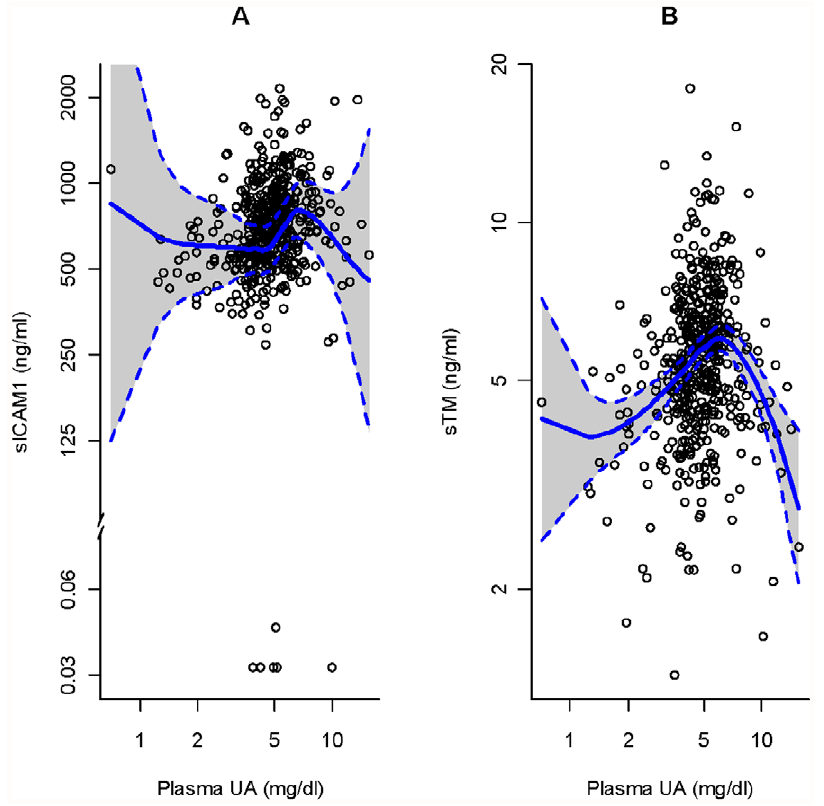
Figure 2. Correlations between plasma levels of UA and those of sICAM-1 or sTM during an acute episode of P.falciparum malaria. The levels of UA, sICAM-1 and sTM were quantified in plasma samples from 487 Malian children at their first episode of uncomplicated P. falciparum malaria and their relationships analyzed. A. The graph shows a positive linear correlation between UA and sICAM-1 levels, but not at the lowest and highest UA levels measured. B. The graph shows a positive linear correlation between UA and sTM levels, but not at the lowest and highest UA levels measured. The blue line in each graph is the loess smooth using the default values [47], showing a moving average line with 95% pointwise confidence intervals.